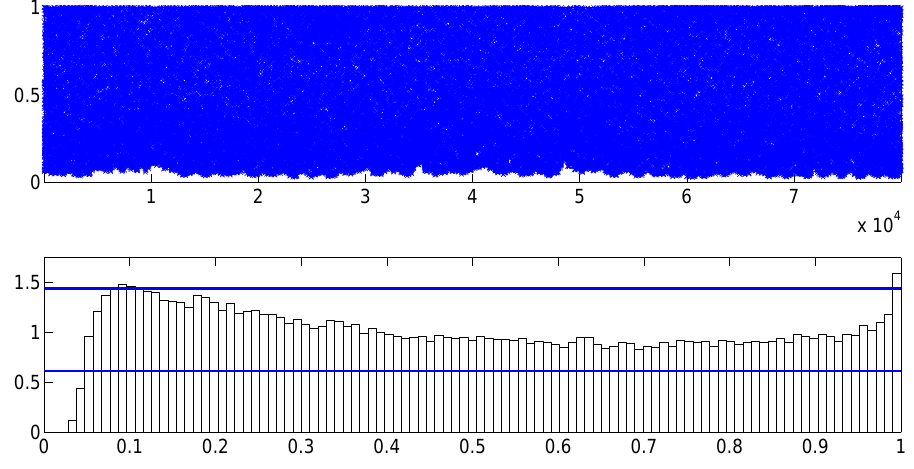
Figure 11. Scatter plot ( top ) and the histogram ( bottom ) of the PITs produced by the fitted TSCD-W model to the Boeing transaction data. The two horizontal lines in the histogram plot are the 95% confidence intervals of the uniformity, constructed under the normal approximation of a binomial distribution, the calculation of which is detailed in Diebold et al. (1998).